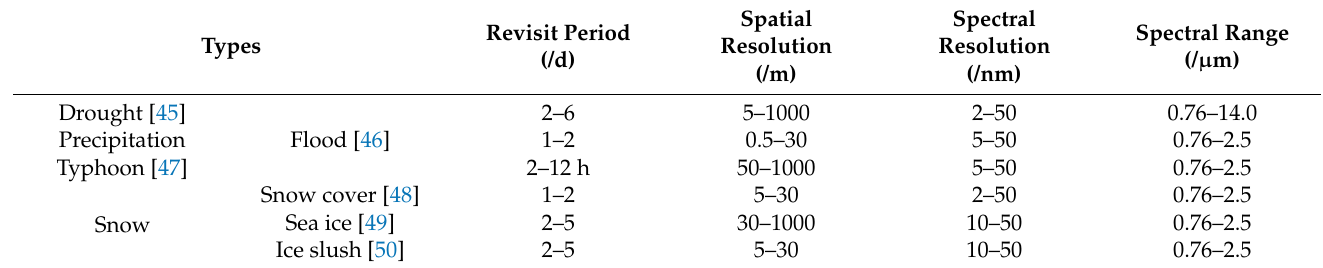
Table 2. Desired specifications of sensor focusing on meteorological